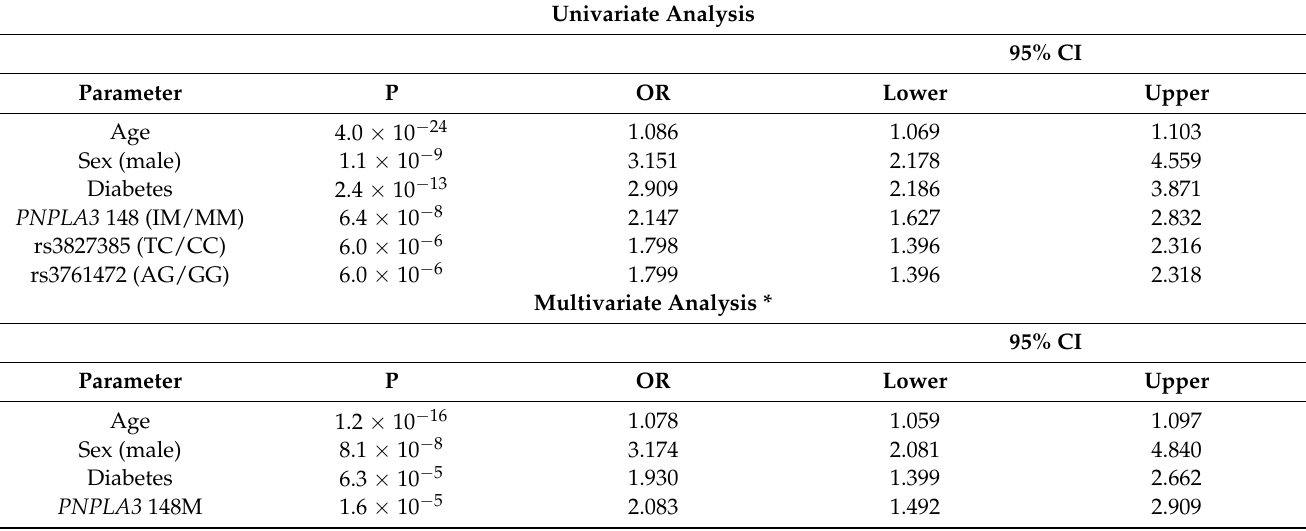
Table 3. Regression Analysis for possible HCC risk